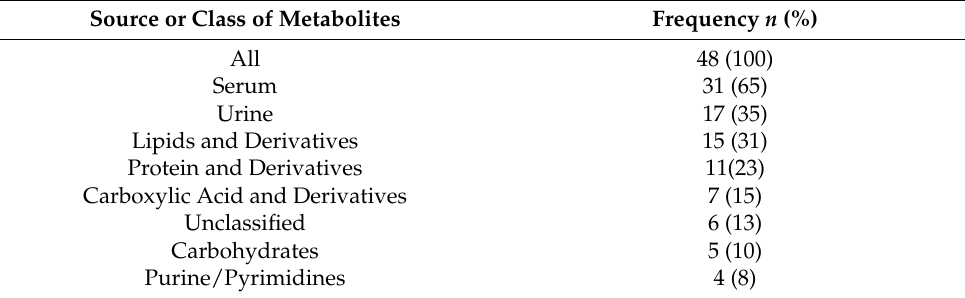
Table 3. Categorization of the metabolites based on biofluid and their chemical class.